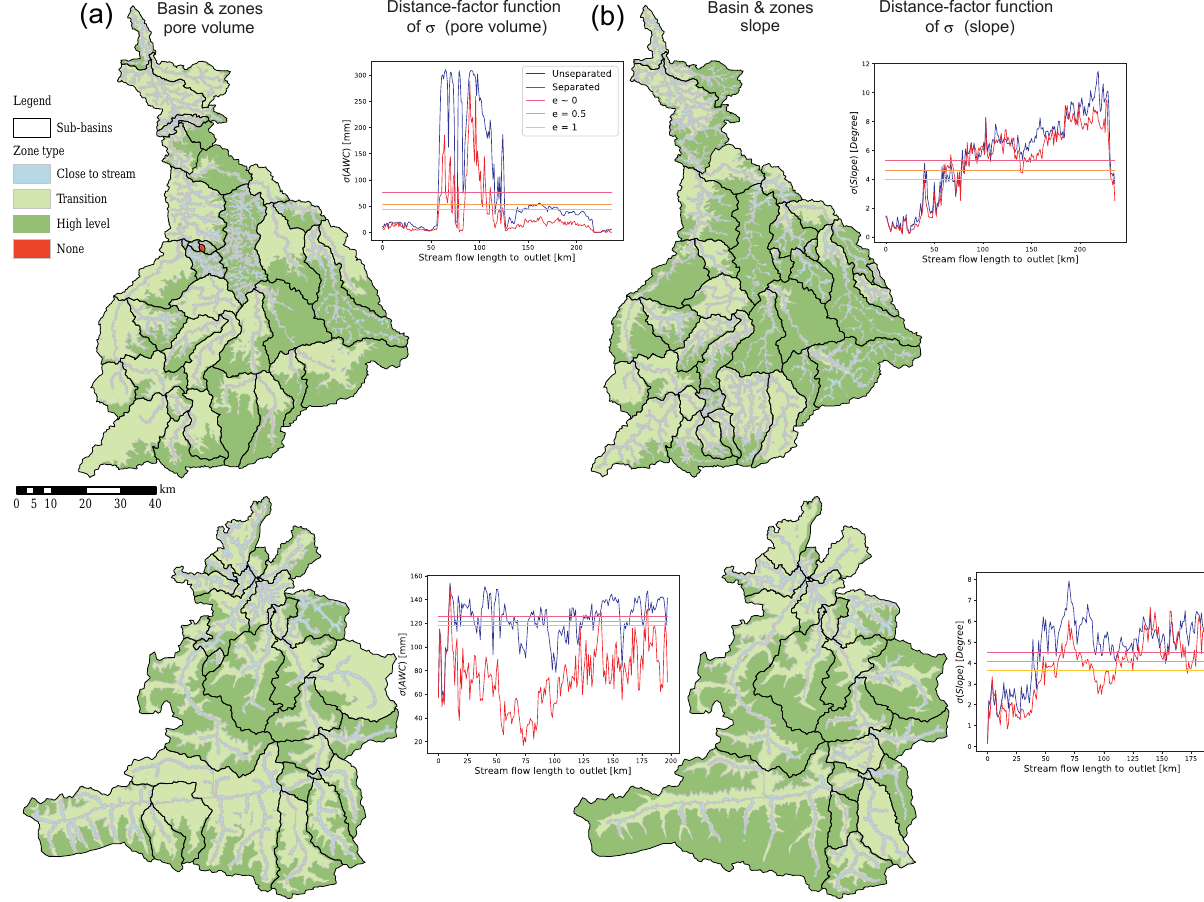
Figure 13. Results of ACS application for resampled catchments of the Mulde and Salzach (from top to bottom) sub-basins based on resampled pore volume (a) and slope (b) . Comparison of σ U (C) and σ S (C) for each application (red and blue